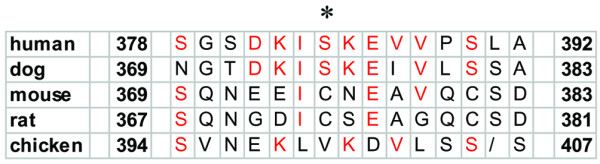
Cross-species comparison of the BRCA2 homologue: Alignment of the predicted BRCA2 amino acid sequence of human (U43746), dog (NP001006654), mouse (U89652), rat (U89653) and chicken (NP989607). Amino acid sequences identical in humans, dog, rodents and chicken are in red. The asterisk indicates the position of the S384F variant.